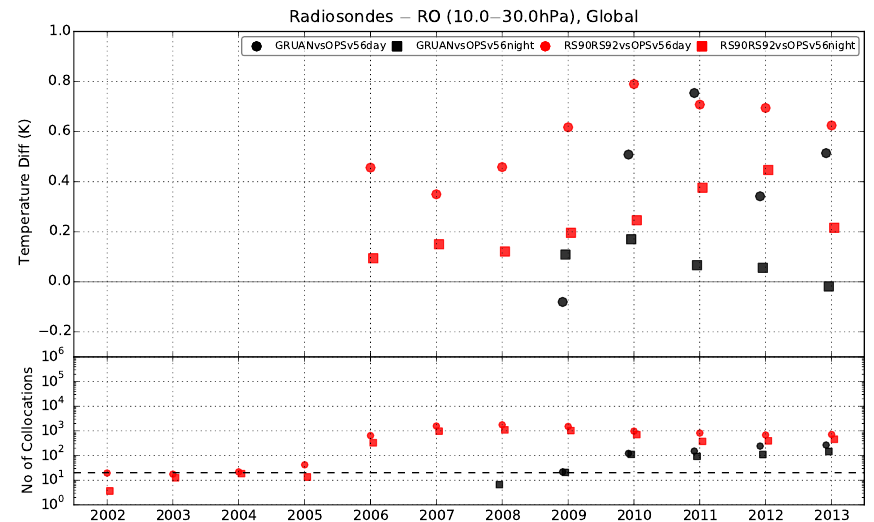
Figure 12. Similar layout as Fig. 4 but showing daytime and nighttime differences for GRUAN versus GPSRO and RS versus GPSRO, for the stratospheric pressure layer 10 to 30hPa.